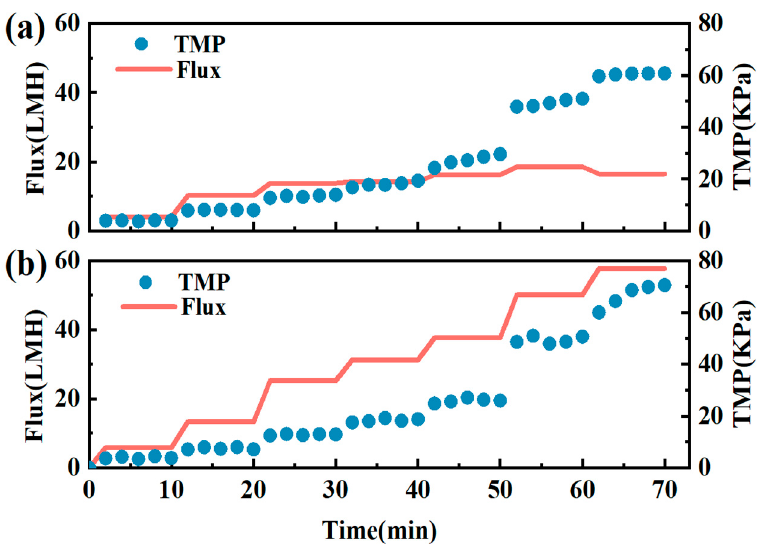
Figure 2. Impact of the in situ fouling control on critical flux: ( a ) filtration without fouling control; ( b ) filtration with in situ fouling control.